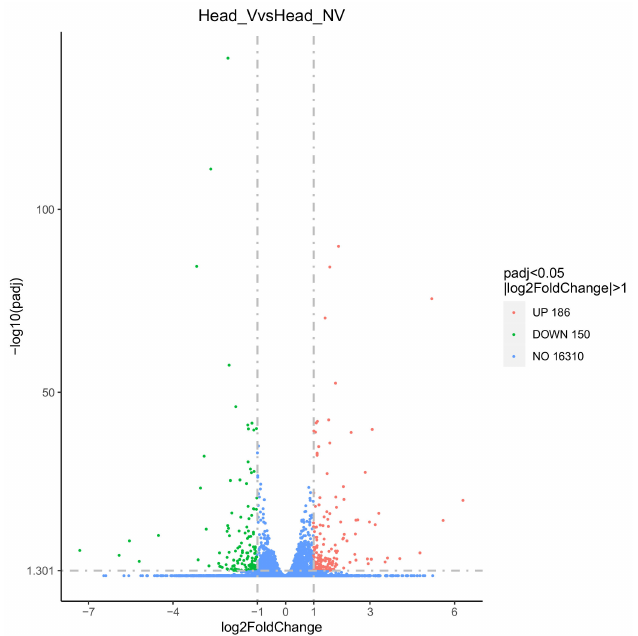
Figure 3. Volcano plot of differentially expressed genes (DEGs) in viruliferous and non-viruliferous SBPH heads; Y-axis represents − log 10 (padj). Red points indicate up-regulated DEGs, green points indicate down-regulated genes, and blue points indicate genes with no significant